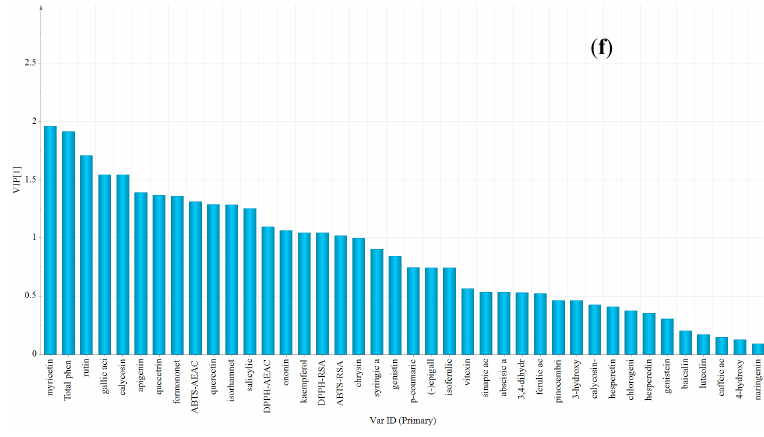
Figure 4. The VIP plot by OPLS-DA corresponding with discrimination between ( a ) Acacia versus rest; ( b ) Vitex versus rest; ( c ) Linden versus rest; ( d ) Rapeseed versus rest; ( e ) Astragalus versus rest and ( f ) Codonopsis versus rest.